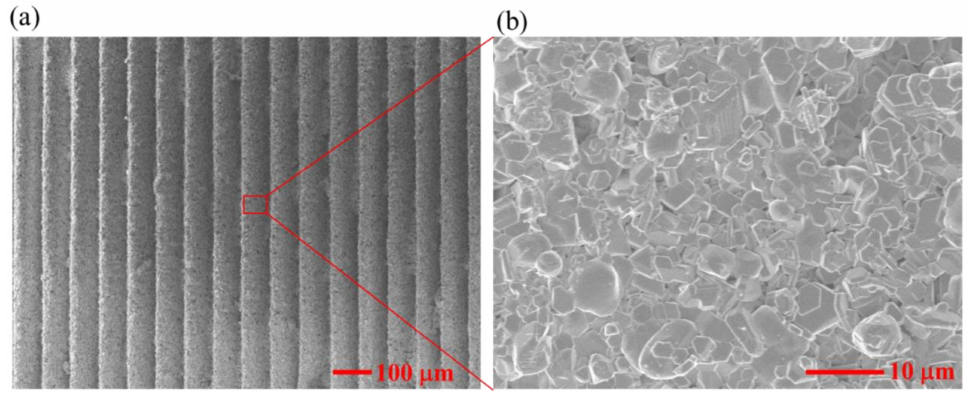
Figure 3. SEM images of the microstructures of stereolithographic additively manufactured Al 2 O 3 . ( a ) At the 100 µ m scale; ( b ) At the 10 µ m